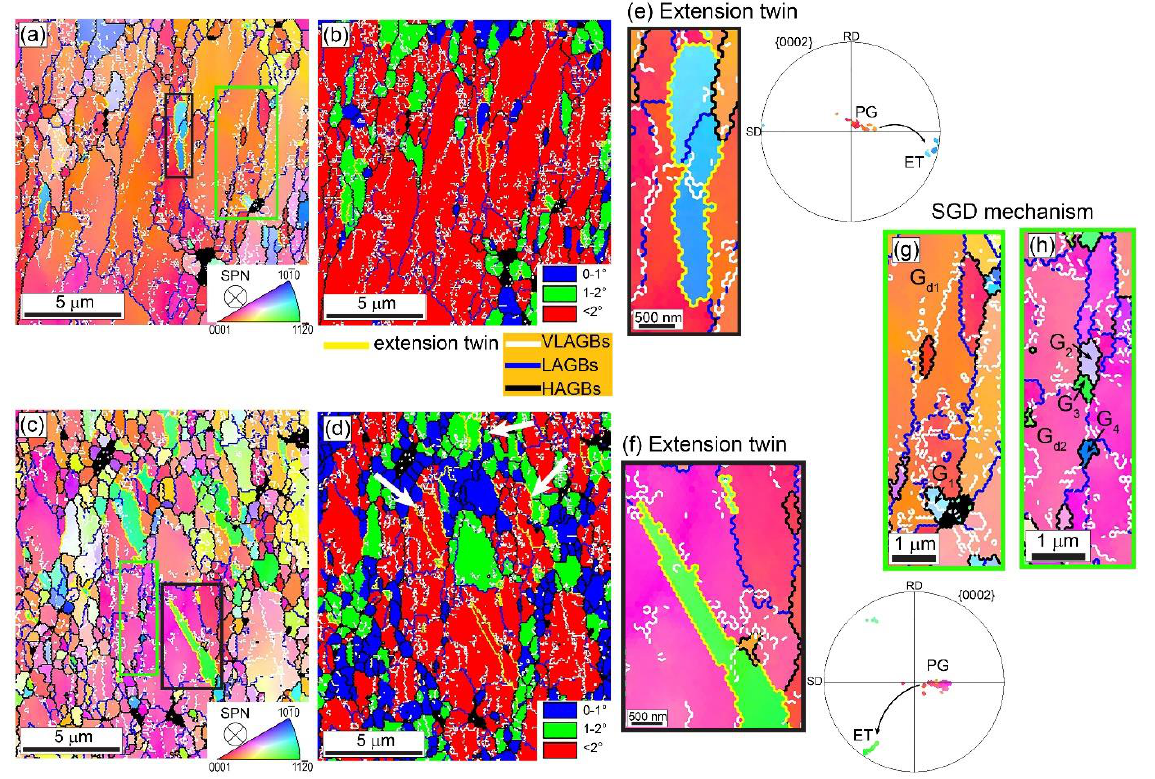
Figure 9. IPF and GOS maps of selected regions from the microstructures of: ( a , b ) HPT-processed (from Figure 2) and ( c , d ) annealed Mg-1.4Nd at 250 °C for 1 h (from Figure 2) showing the presence of ( e , f ) an extension twin (black box) and corresponding {0002} pole figure and ( g , h ) a sub-grain development mechanism (green box).